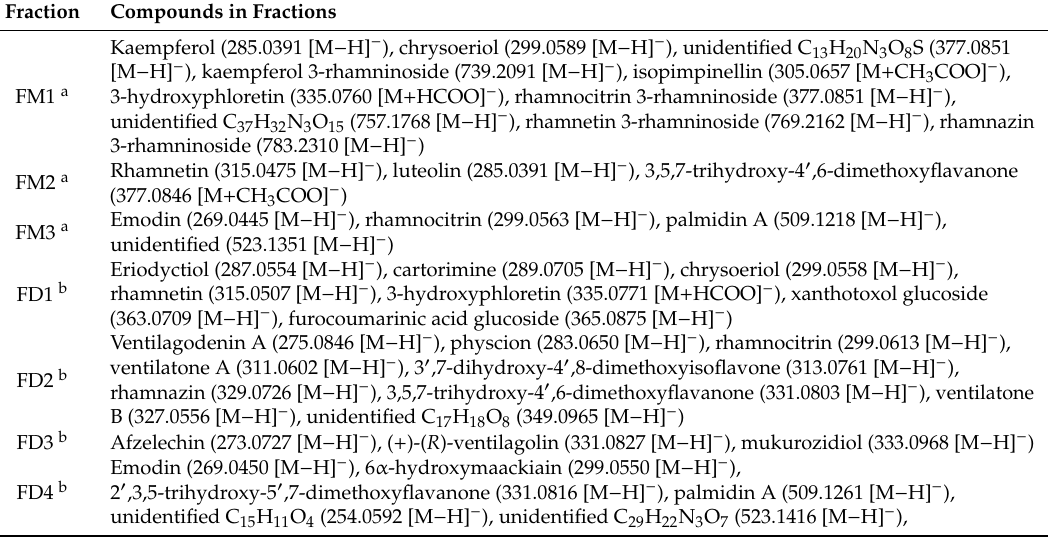
Table 4. Antibacterial and antifungal agents from the HPLC fractions of V. denticulata , tentatively identified by ESI-HRMS analysis based on the putative compounds listed in Table